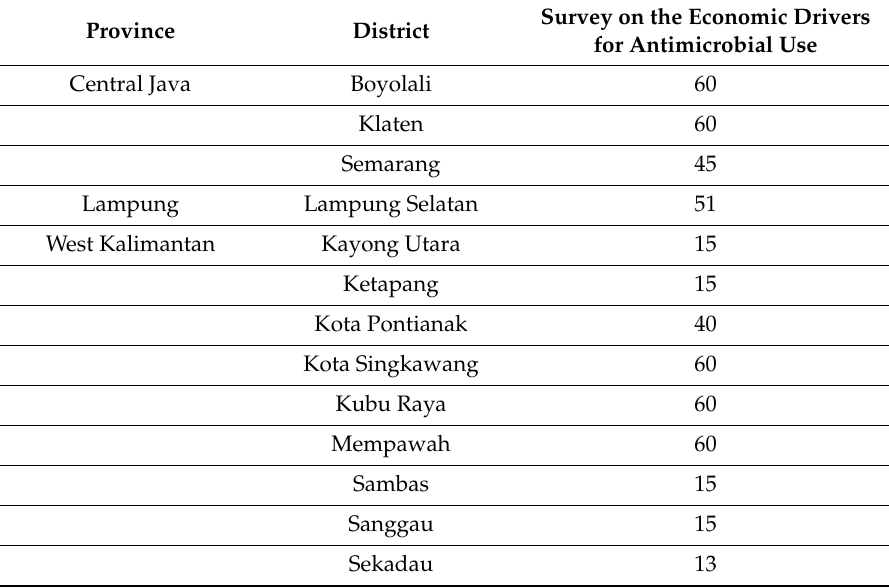
Table 4. Geographical distribution of broiler farms included in the